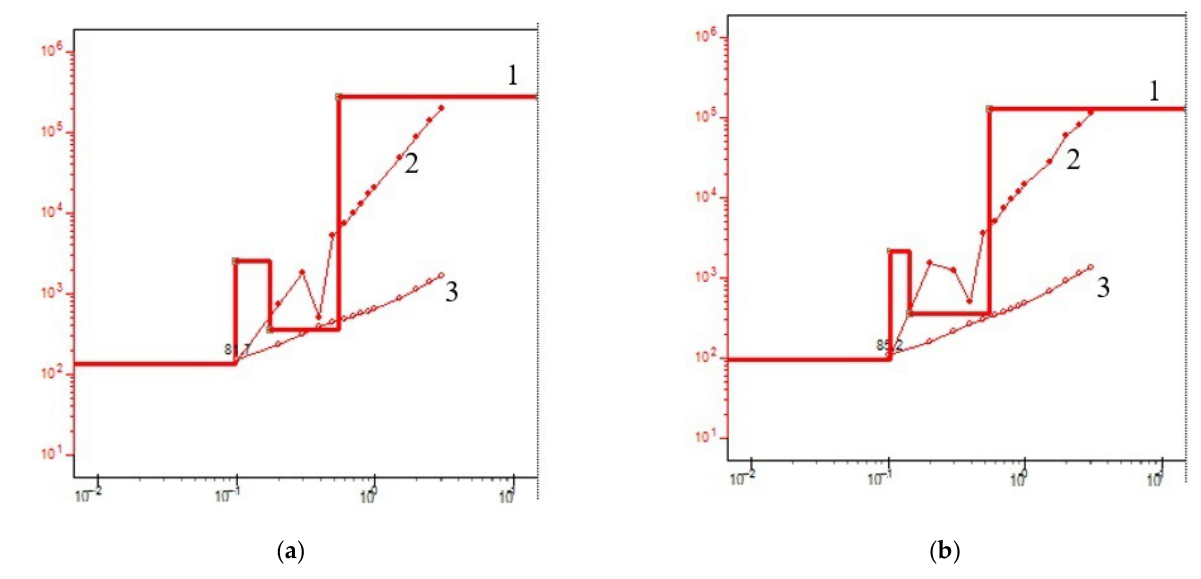
Figure 5. Electrical resistivity curves and models of soil profiles at investigated sites. Heavy red line 1: denotes the layer model; thin line 2: denotes measured values; thin line 3: denotes calculated model curves. Vertical scale: ER values (Ωm); horizontal scale: AB/2 distance (m). ( a ) Postfire plot; ( b ) control plot. Table 4. Electrical resistivity (Ωm).